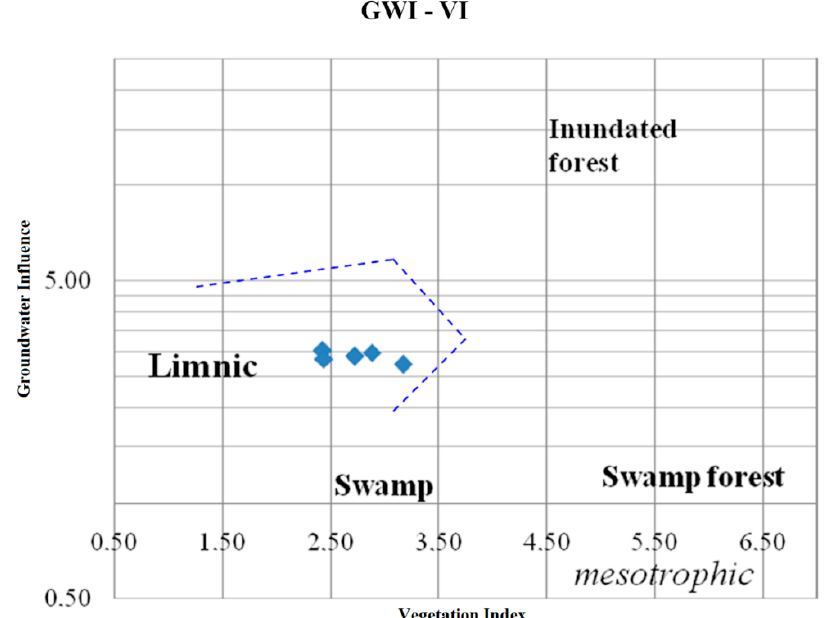
Figure7. PositionofthecoalyshalefromLaCumbredepositonafaciesdiagram[32](modifiedaccording Figure 7. Position of the coaly shale from La Cumbre deposit on a facies diagram [32] (modified to meta-lignite according to meta-lignite macerals).